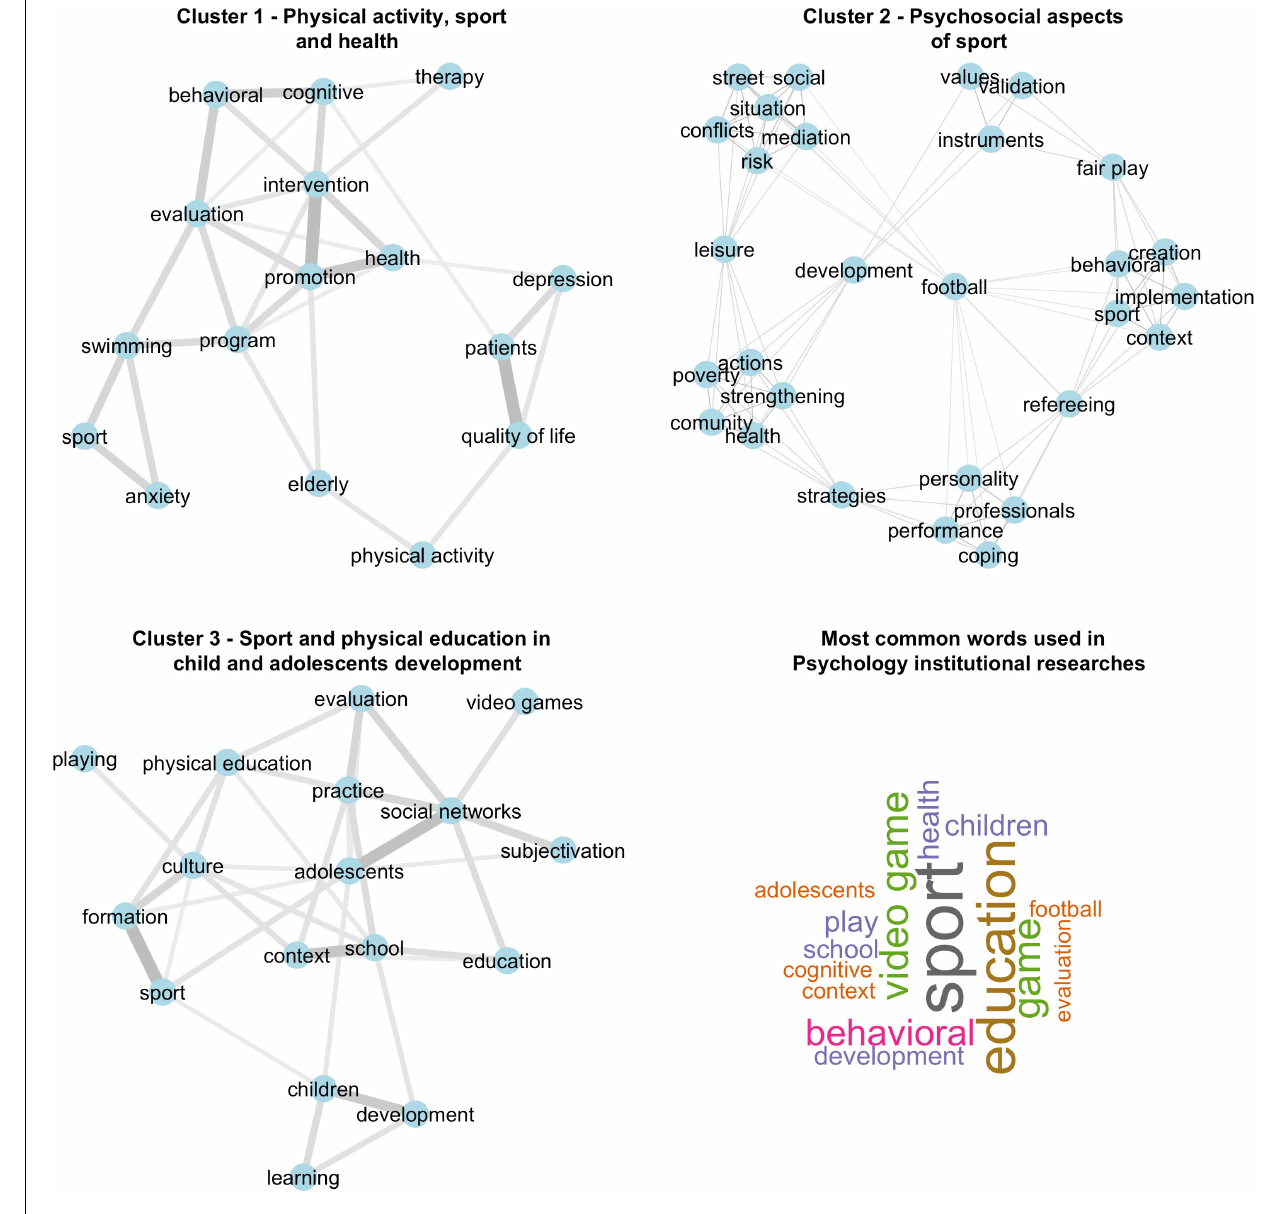
FIGURE 5 | Correlation network and a word cloud of title words of Psychology